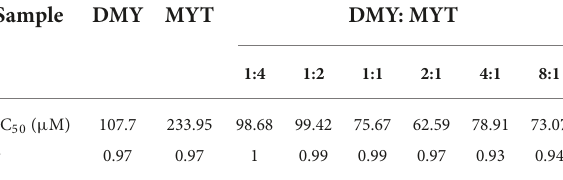
TABLE 3 Half-inhibitory concentrations of drugs on tyrosinase in B16F10 cells.